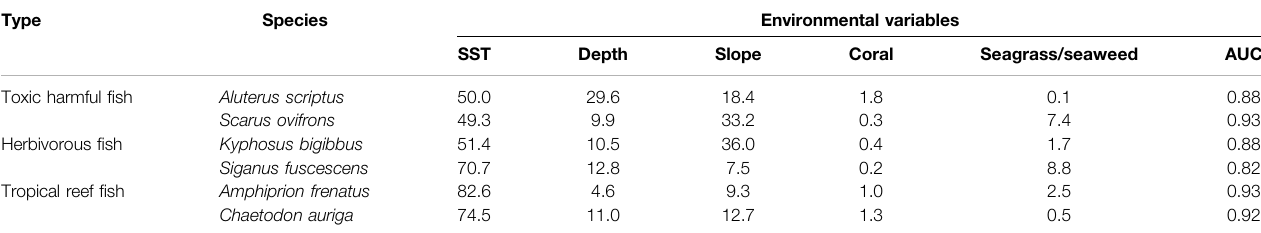
TABLE 4 | Contribution (%) of each environmental variable and the area under the curve (AUC) of the species distribution models for six fi sh species.